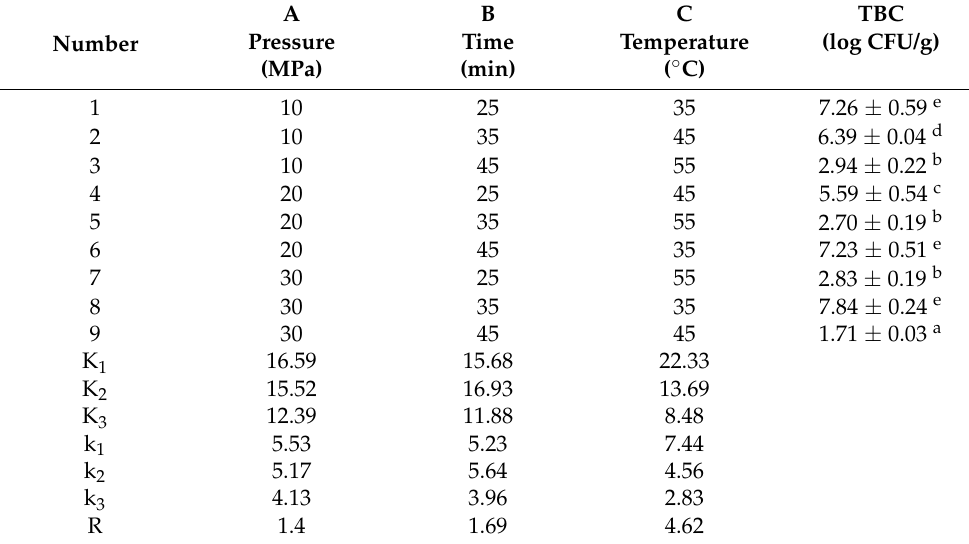
Table 1. Range analysis of orthogonal experiment for pressure, treatment time and